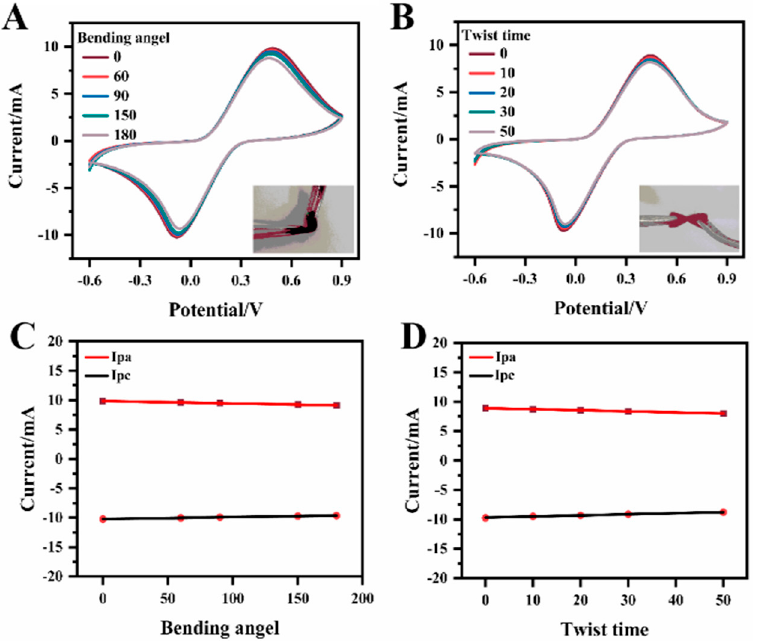
Figure 4. CVs of MIP@CF electrode with different bending angle ( A ) and twist time ( B ) in 5.0 mmol · L − 1 K 4 [Fe(CN) 6 ] with 0.1 mol · L − 1 KCl at the scan rate of 50 mV · s − 1 ; Relationship between the anodic (I pa ) and cathodic peak (I pc ) currents vs. bending angle ( C ) and twist time ( D ).